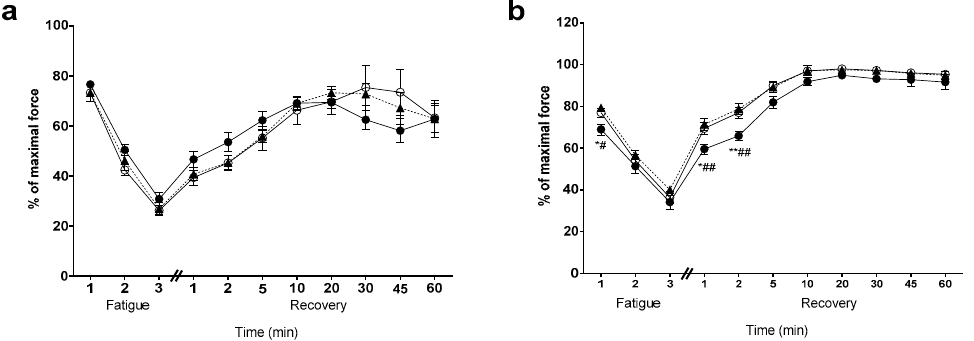
Figure 3. Fatigue and recovery for the EDL and SOL muscles. CON, open circles ( ); HIGH, closed (cid:35) triangles ( (cid:78) ); YEAR, closed circles ( (cid:8) ). ( a ) There was no e ff ect of diet intervention or dose administration on the EDL fatigue and recovery from fatigue; ( b ) in the SOL however, it was found that the YEAR animals were slightly more fatigable during the first minute of fatigue when compared to the CON and HIGH groups; ( b ) the YEAR animals displayed delayed recovery at one min and two min when compared to the CON and HIGH groups. Symbols indicate: * p < 0.05, ** p < 0.01; di ff erent from CON, # p < 0.05, ## p < 0.01; di ff erent from